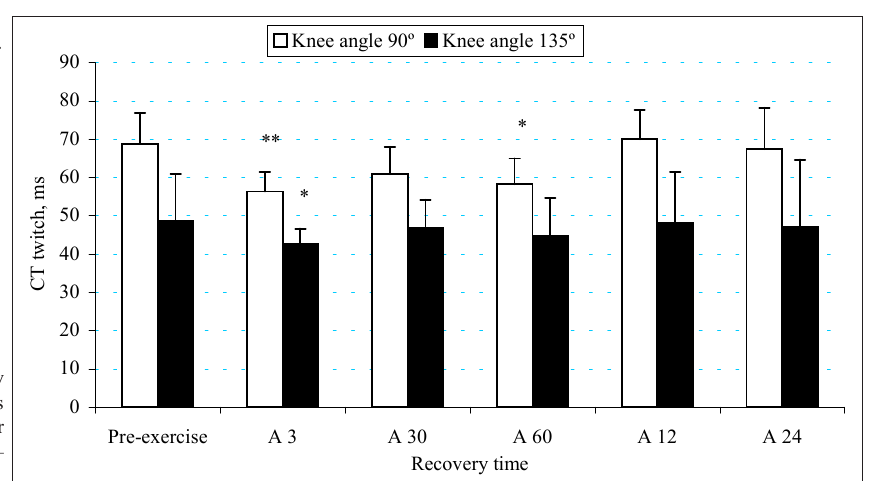
Table 1. General characteristics and torque (in newtons) at different frequencies of electrical stimulation plus maximal voluntary contraction (MVC) in the force generating capacity test (FGCT) before exercise at 90 ˚ and 135 ˚ angles Note. Pt is twitch peak torque; P 10, P 20 and P 50 stand for peak torques at 1, 10, 20 and 50 Hz of electrical stimulation respectively; MVC is maximal voluntary contraction. Values are means ± SD. Fig. 2. Mean values of duration of a single twitch muscle contraction time (CT) evoced by a single electrical impulse before the exercise, immediately after it 3 (A 3), 30 (A 30), 60 (A 60) min, 12